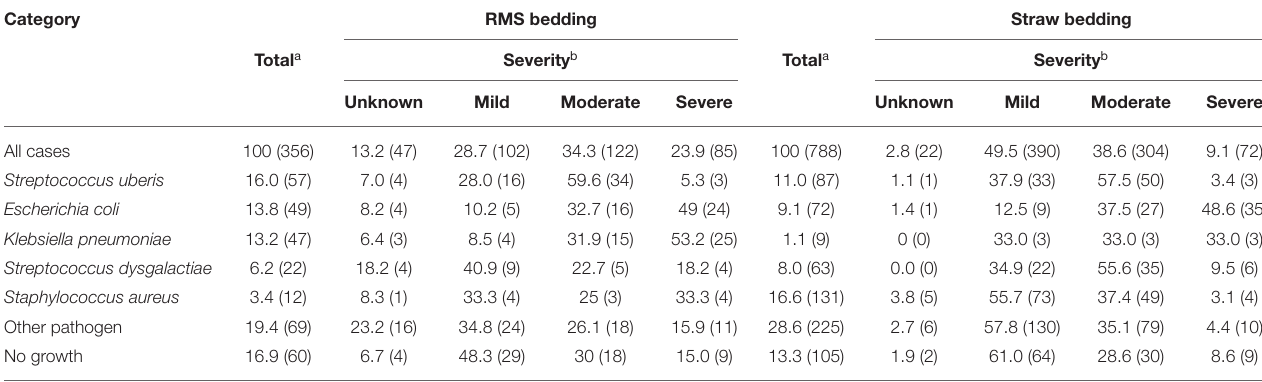
TABLE 2 | Percentage (number) of clinical mastitis cases by bedding type, bacterial species, and severity among 1,144 clinical mastitis cases obtained on 26 farms using recycled manure solid (RMS) bedding and 60 farms using straw bedding. Category RMS bedding Straw bedding Total a Severity b Total a Severity b Unknown Mild Moderate Severe Unknown Mild Moderate